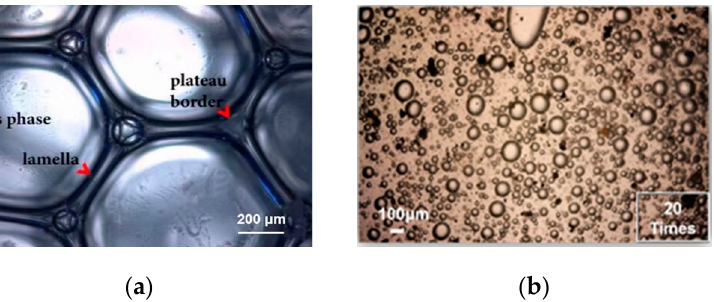
Figure 4. Images of the conventional foam system and the three-phase foam system: ( a ) conventional foam (adopted from [49]); ( b ) three-phase foam (magnified by 20 times).